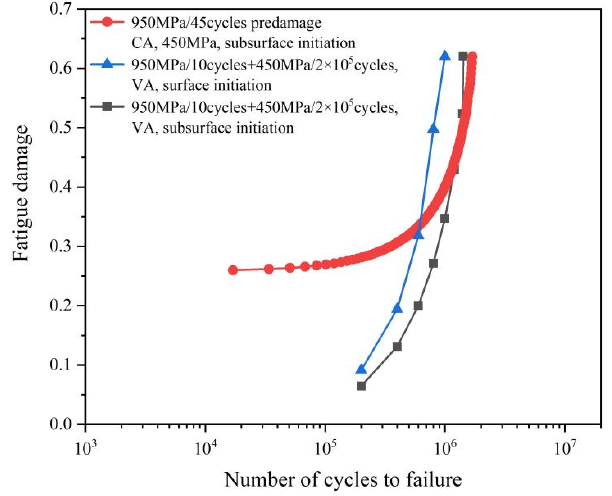
Figure 10. Comparison of stress blocks and LCF predamage fatigue